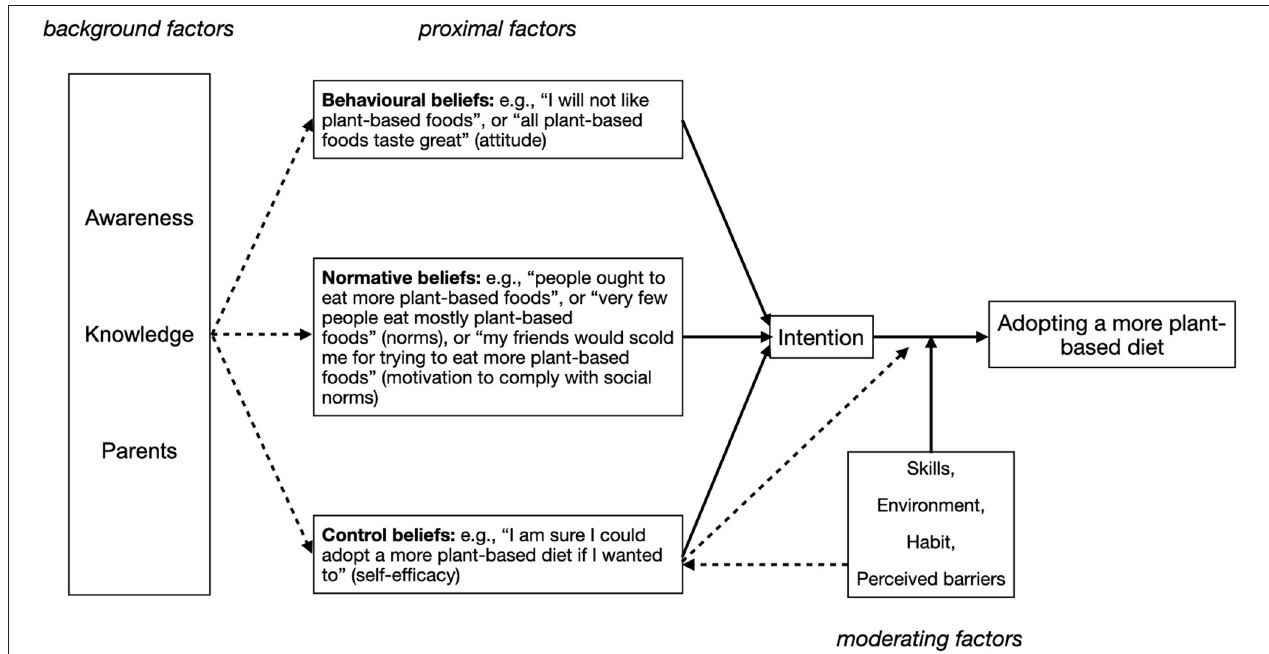
FIGURE 1 | The reasoned action approach (RAA) as applied to examining adolescents’ willingness to adopt a more plant-based diet. Choosing more plant-based food options is defined as the target behavior. Behavioral, normative (including the motivation to comply with norms), and control beliefs depicted as proximal factors relate to the intention to choose more plant-based food options. Parents, as well as adolescents’ degree of awareness of the benefits of eating more plant-based foods and their knowledge concerning a plant-based diet were identified as (potentially) informing these beliefs. Skill in preparing/procuring a plant-based meal, environmental availability of plant-based food options, habits impacting the adoption of a more plant-based diet, and perceived barriers toward adopting a more plant-based diet were considered potential